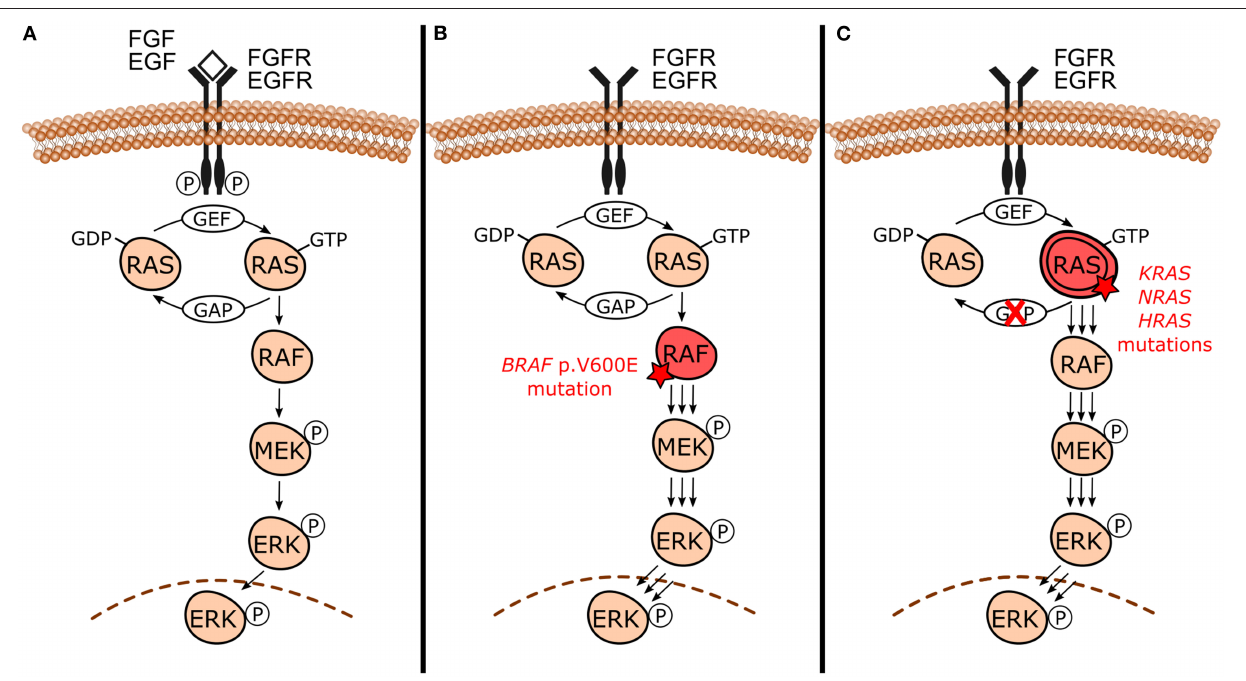
FIGURE 1 | Canonical mitogen-activated protein kinases/extracellular signal-regulated kinases (MAPK/ERK) signaling pathway under normal circumstances and in the presence of activating mutations. (A) Canonical RAS-RAF-MEK-ERK cascade and its normal activation by external signals (e.g., FGF and EGF growth factors) binding to receptor tyrosine kinases [e.g., fibroblast growth factor receptor (FGFR) and epidermal growth factor receptor (EGFR)]. This interaction triggers signaling through RAS-GTP, RAF, MEK, and ERK culminating with the action of phosphorylated ERK in its substrates and the regulation of cellular biological functions. In the absence of external stimulus, active RAS-GTP switches to its inactive form RAS-GDP by hydrolysis due to GAPs action. (B) In the presence of BRAF p.V600E mutation, BRAF constitutively activates MAPK/ERK signaling even in the absence of growth factors and dimerization with RAS, sustaining MAPK/ERK signaling. (C) Activating mutations in RAS genes ( KRAS, NRAS , and HRAS) lead to unbalance between inactive and active RAS forms toward the active state (RAS-GTP) either by reducing GTP hydrolysis or by increasing the rate of GTP loading. This mechanism constitutively activates MAPK/ERK signaling even without external stimulus, sustaining its